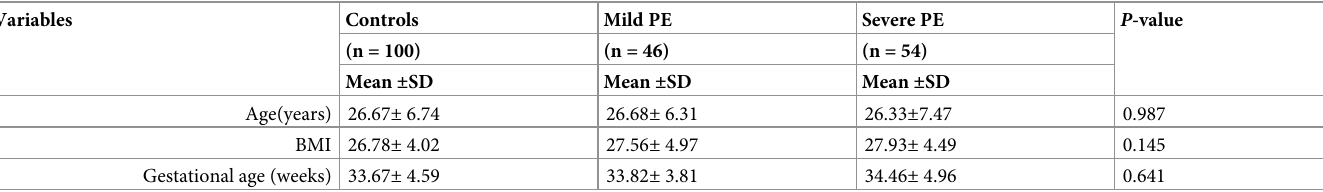
Table 1. Age and clinical characteristics of the patient’s groups (mild and severe preeclampsia) and controls. Variables